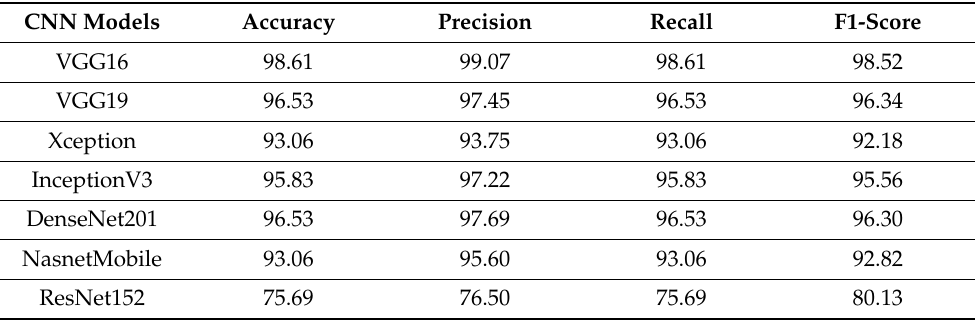
Table 8. Weighted average of performance metrics by different deep learning networks for facial images classification.